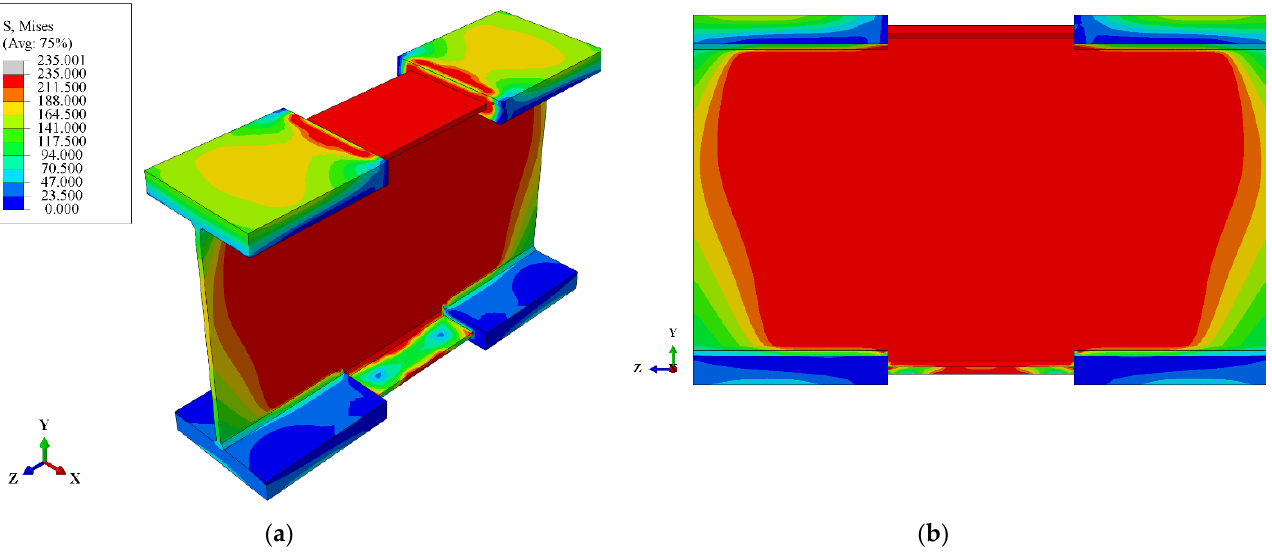
Figure 16. von Mises’ stress map (MPa) for LRPD IPE400 (DP2) at the ultimate loading condition: ( a ) perspective view; ( b ) lateral view.